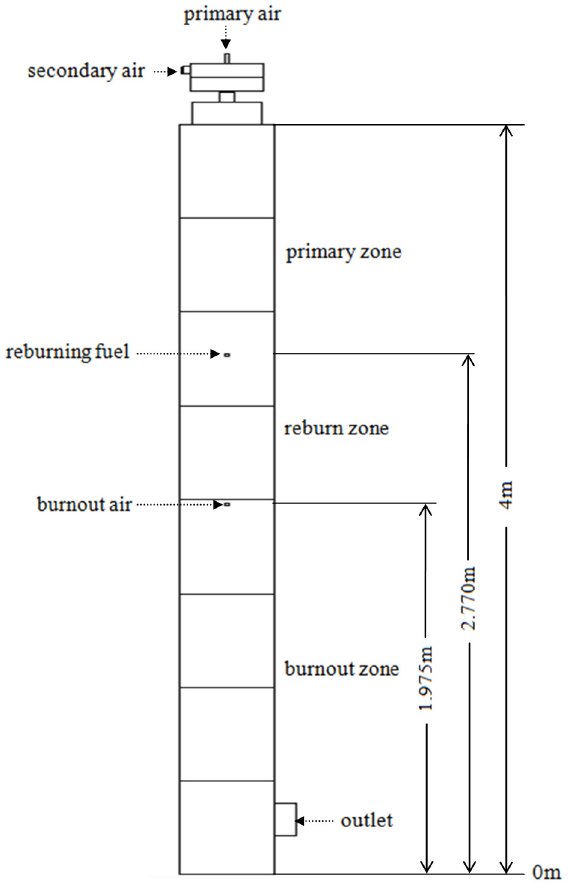
Figure 1. Simplified structure of the